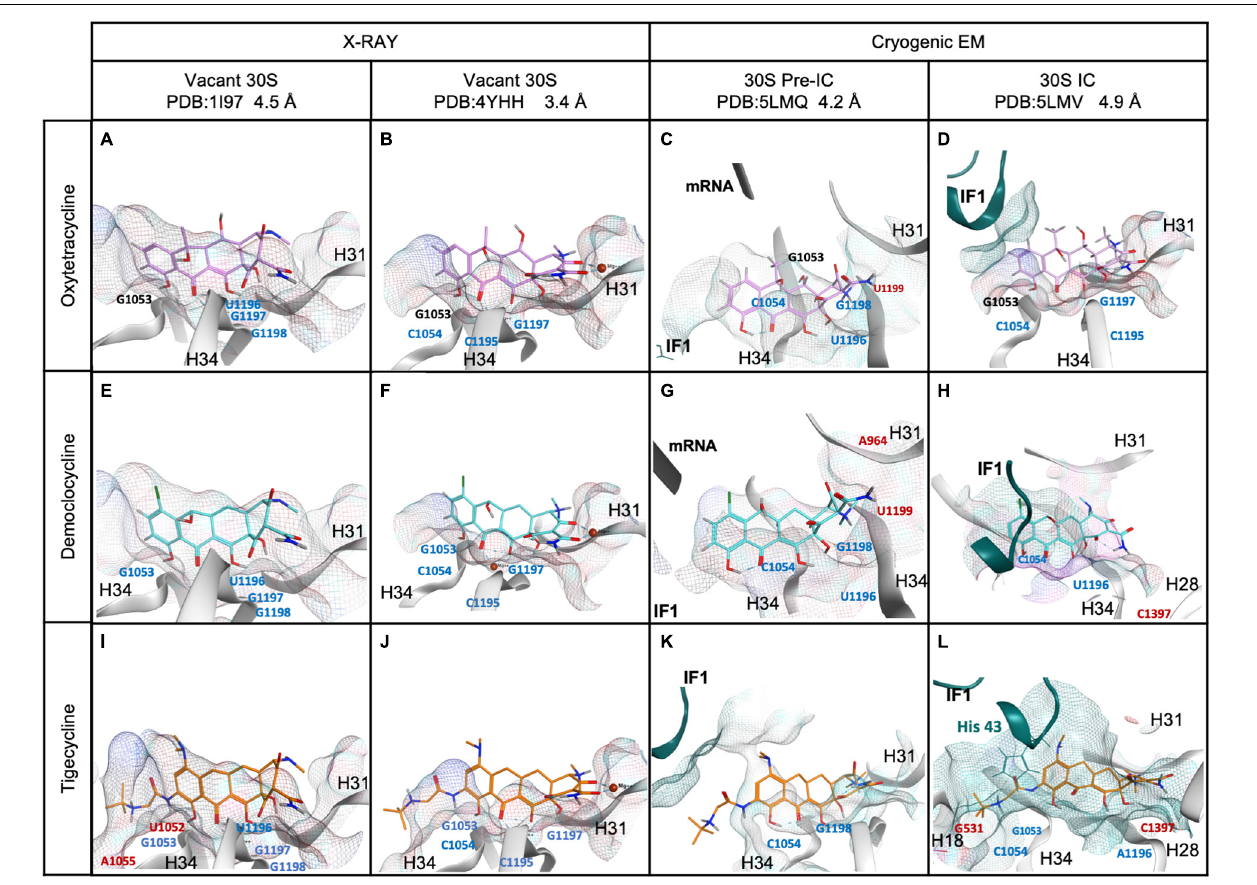
FIGURE 5 | Comparison of Tetracyclines in 30S complexes obtained by X-ray diffraction, cryogenic electron microscopy, and molecular modeling approach. (A–D) Oxytetracycline, (E–H) Demeclocycline, and (I–L) Tigecycline. Labeled nucleotides in 16S (gray ribbon), mRNA (black ribbon), red labeled represent nucleotides that appeared once, blue show their appearance in two or three models, and black indicates that the contact was present in all 30S models of the indicated tetracycline. IF1 is shown in dark aquamarine ribbons, while interacting residues are shown in sticks. The structural models were generated from PDBs 1I97 and 4YHH for vacant 30S subunits, 5LMQ, and 5LMV for the 30S pre-IC and IC,